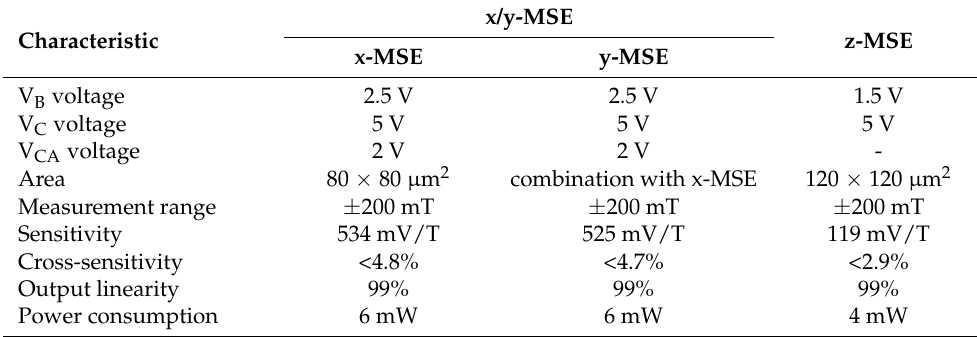
Table 2. Summary of the performances for the magnetic